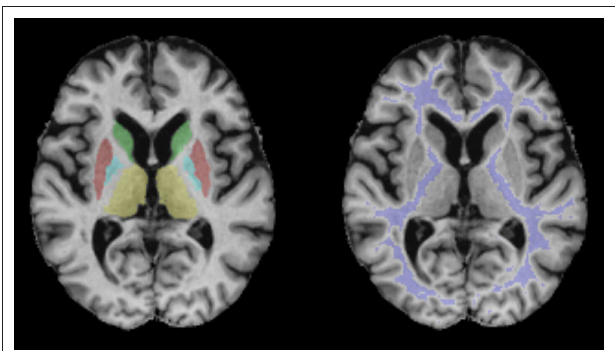
FIGURE 1 | Regions of interest used for the evaluation of qMRI data demonstrated for a representative subject in MNI 152 standard space ( z = 8). Blue: pallidum; red: putamen; green: caudate nucleus; violet: white matter; yellow: